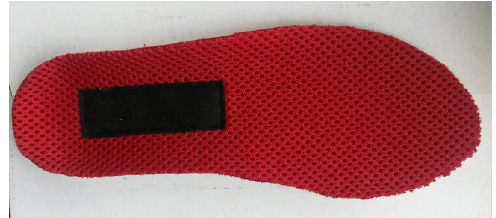
Figure 20. The footwear insert made of spacer knitted fabric.